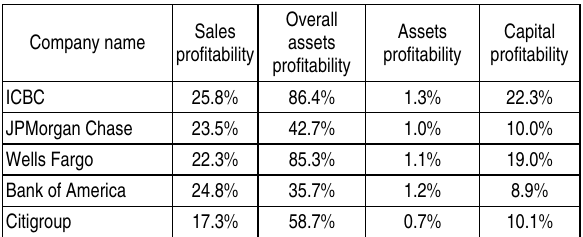
Table 7. Financial results coefficients of top 5 major world banks, bln US dollars